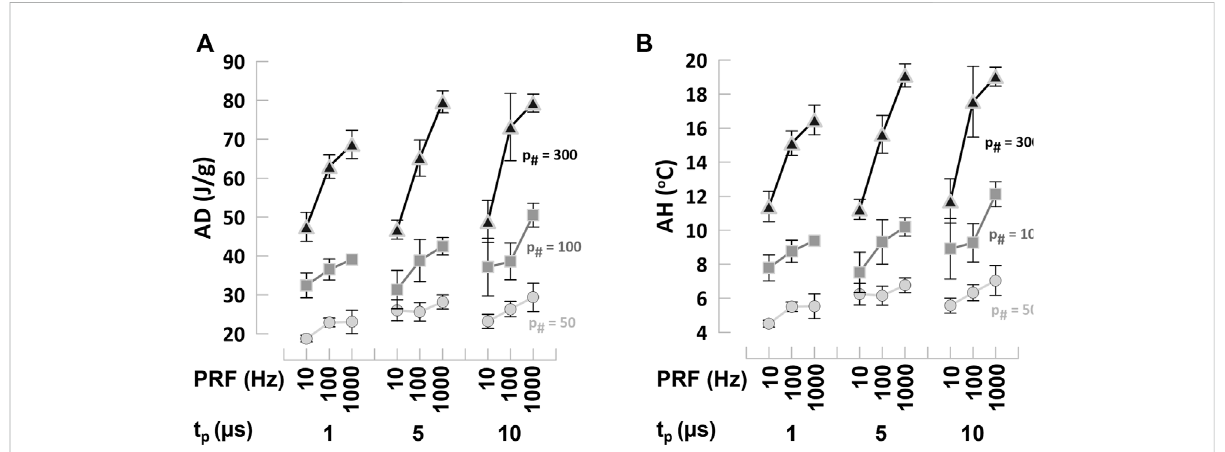
FIGURE 5 Absorbed dose and adiabatic heating at the EFT for cell death in hiPSC-CMs (A) Absorbed dose (AD) and (B) adiabatic heating (AH) calculated from cell death EFTs for all the combinations of PEF parameters tested. Trains of 50, 100, and 300 pulses (left to right panels) and t p = 1, 5, and 10 µs were applied at PRF = 10, 100, and 1,000 Hz to hiPSC-CMs. See text for more details. Symbols legend as labeled: p # = 50 light gray circles, p # = 100 gray squares, p # = 300 black triangles. The error bars represent the standard error for a sample size of n = 3 – 8 for all data